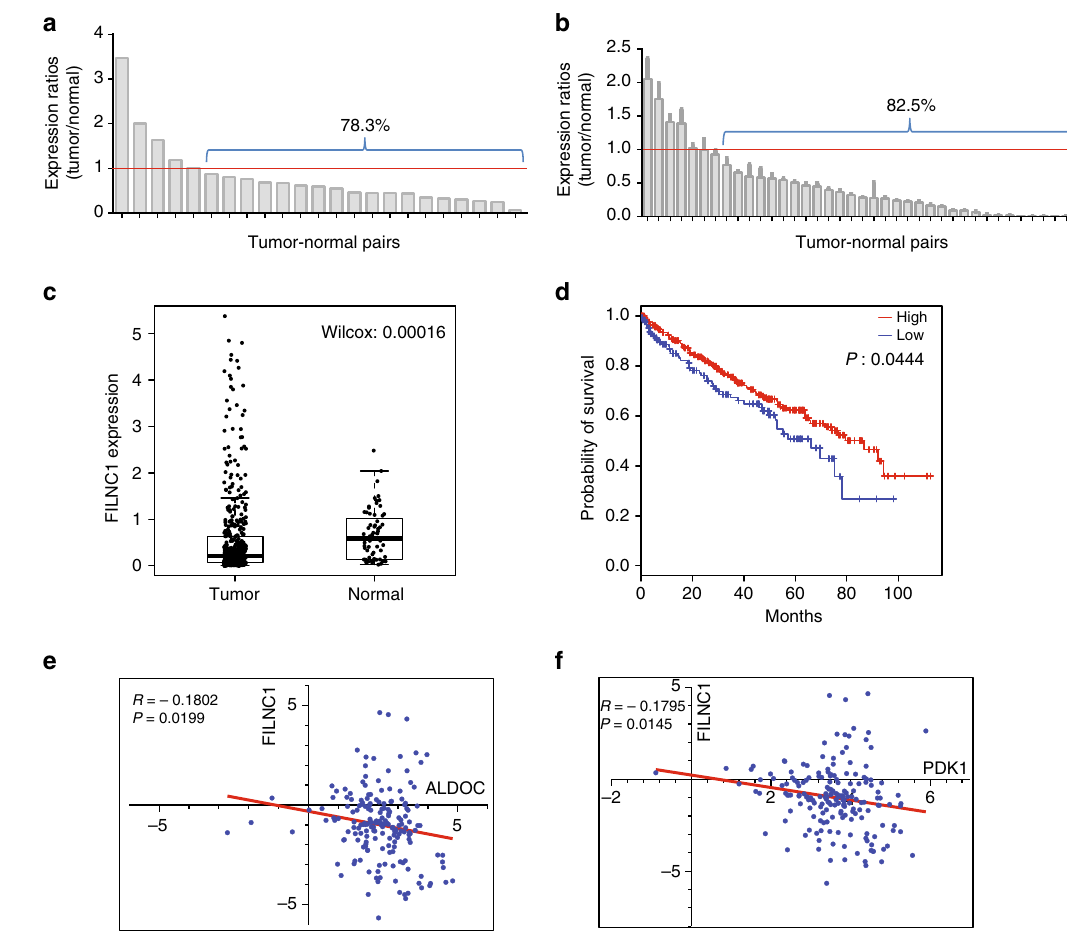
Fig. 7 FILNC1 is highly expressed in kidney and its expression is downregulated in renal cancers. a Bar graph shows the tumor/normal kidney ratios of FILNC1 expression in 23 paired ccRCC and normal kidney samples from the data set generated by Peña-Llopis et al. 29 b Bar graph shows the tumor/normal kidney ratios of FILNC1 expression by real-time PCR from 40 matched ccRCC and normal kidney samples. Values represent mean ± s.d. from three independent measures, two-tailed Student ’ s t -test. c The box plot shows the expression pattern of FILNC1 for ccRCC and normal kidney samples from the TCGA data set. The boxes show the median ± 1 quartile, with whiskers extending to the most extreme data point within 1.5 interquartile range from the box boundaries ( n tumor = 449, n normal = 67, Wilcoxon test). d A Kaplan – Meier plot of renal cancer patients strati fi ed by the expression levels of FILNC1 ( n high = 312, n low = 134, log-rank test). e , f Scatter plots show the inverse correlation of FILNC1 with ALDOC ( e ) or PDK1 ( f ) expression in human renal tumors, (Fig. 3), computational analyses revealed a negative correlation between FILNC1 and ALDOC , or PDK1 in renal cancer (Fig. 7e, f). Together, our data showed that FILNC1 is highly expressed in kidney and downregulated in renal cancers, and that renal cancer patients with low expression of FILNC1 have poor clinical outcomes, providing further support of our functional data.